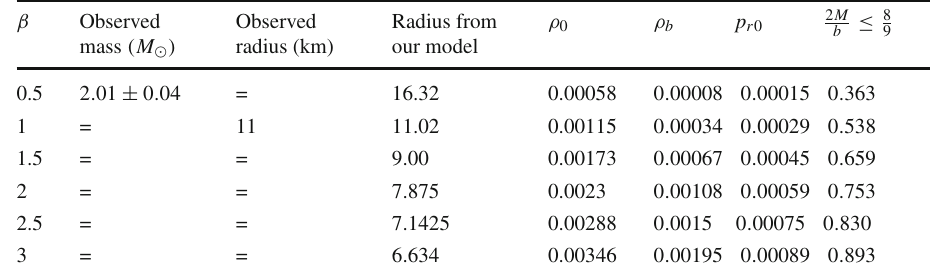
Table 2 Values of different physical parameters considering different values of the model parameter β for PSR